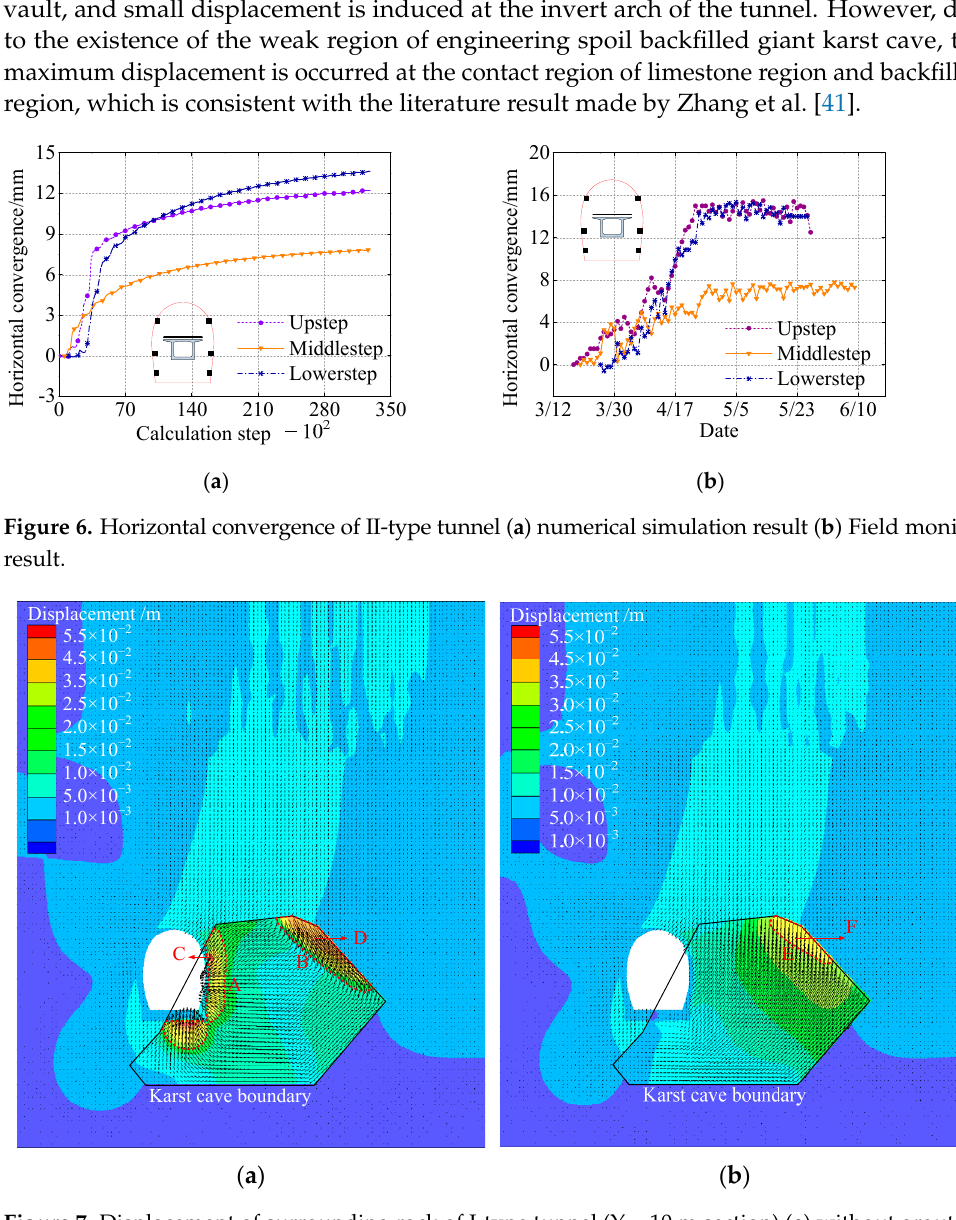
Figure 7. Displacement of surrounding rock of I-type tunnel (Y = 10 m section) ( a ) without grouting ( b ) with grouting.